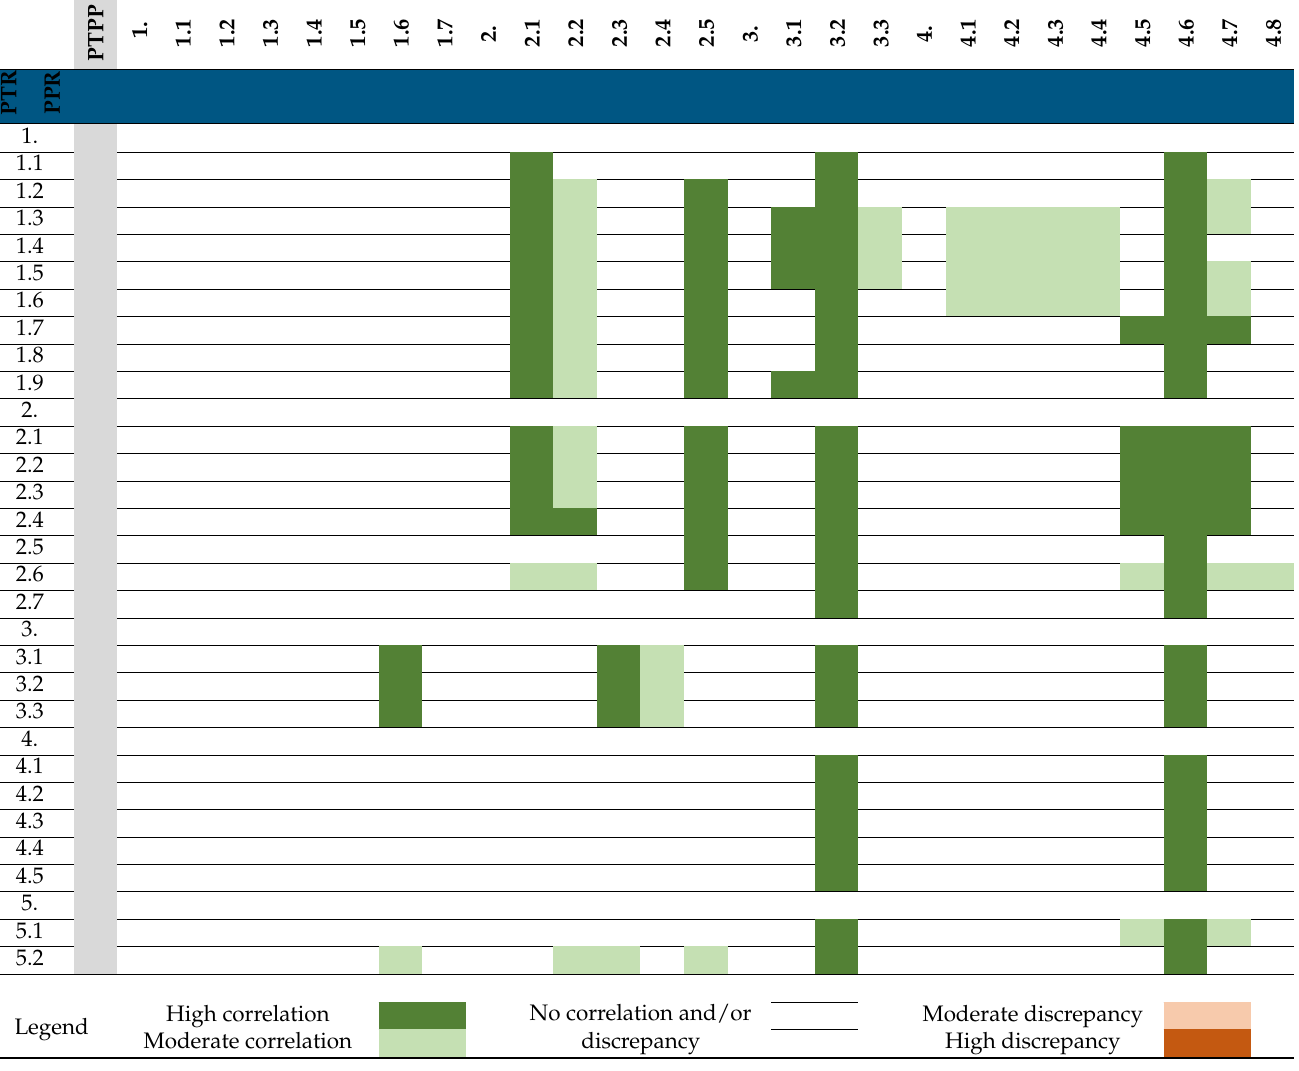
Table 13. Correlation matrix between the objectives of the PTPP of the PRG Revision and the objectives of the PTR and PPR